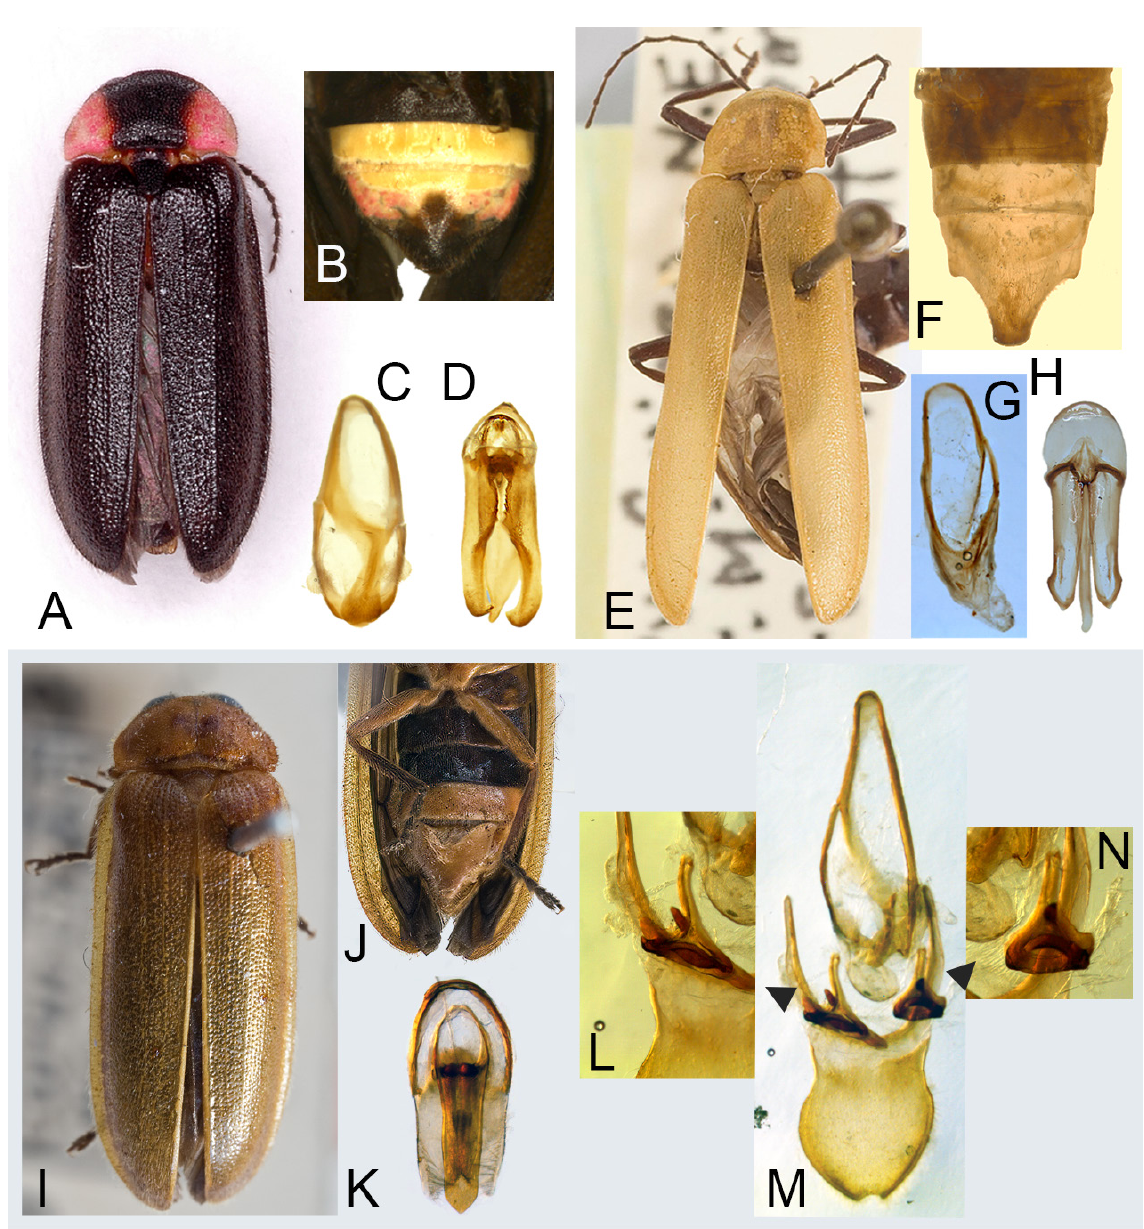
Fig. 4. Generic features. A–D . Aquatica Fu et al. 2010, specimen is Aquatica lateralis (Motschulsky, 1860), ♂, Tokyo (HZNHM). E–H . Missimia Ballantyne, 2009, specimen is Missimia flavida Ballantyne, 2009, holotype, ♂ (BPBM). I–N . Sclerotia Ballantyne, 2016, specimen is Luciola seriata Olivier, 1891, holotype, ♂ (MCSN). A, E, I . Habitus, dorsal view. B, F, J . Terminal abdomen with ventrites 3‒7 visible, ventral view. D, H, K . Aedeagus, ventral (K) and dorsal (D, H) views. C, G . Aedeagal sheath, ventral (C) and dorsal (G) view. L–N . Aedeagal sheath, tergite 8 and lateral sclerites. L, N . Detail right (L) and left (N) sclerite. M . Aedeagal sheath, sclerites and T8, aedeagal sheath to top of page,T8 to foot of page with left and right sclerites (arrowed), ventral view. All images by L.